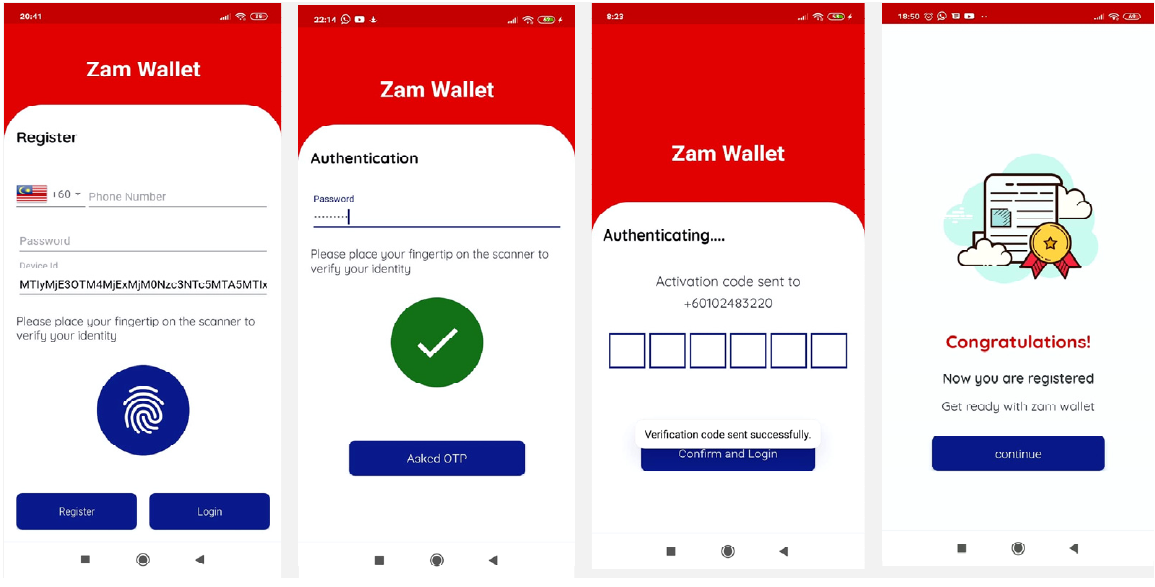
Figure 11. Registration activity proposed method. 2. User